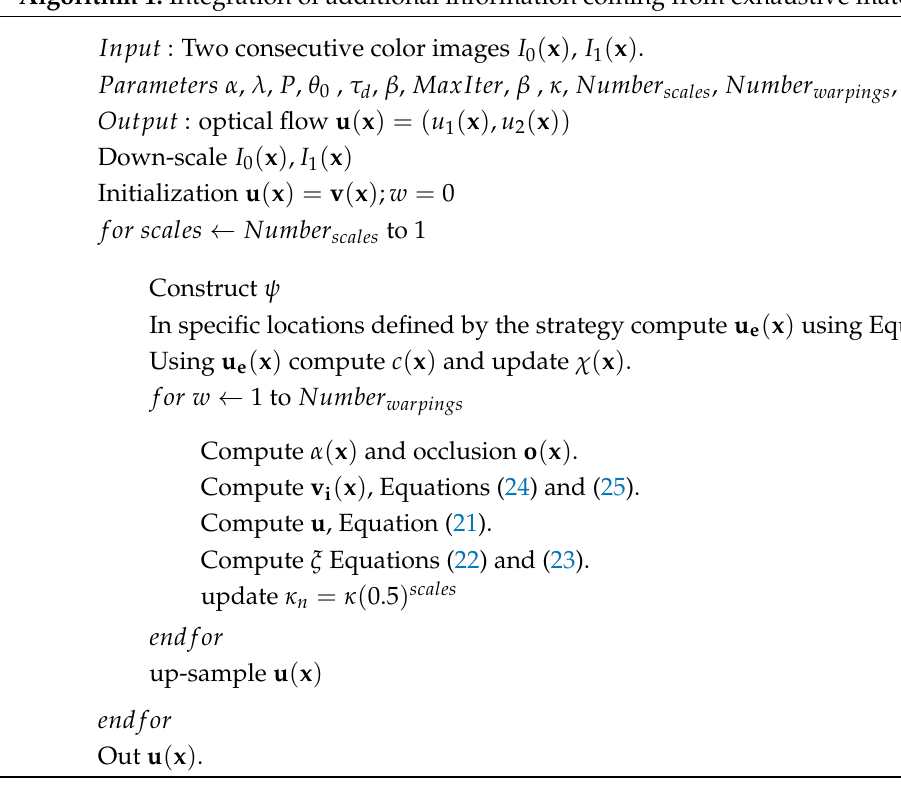
Algorithm 1: Integration of additional information coming from exhaustive